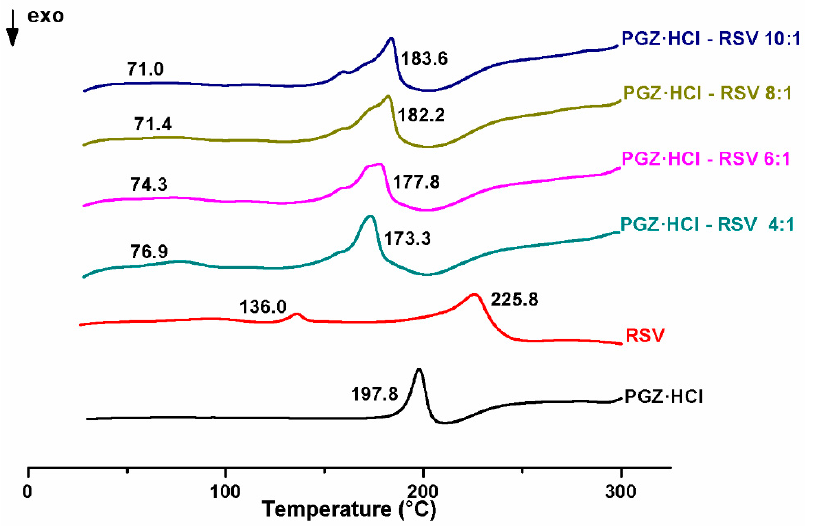
Figure 9. DSC thermograms of the solid forms of PGZ·HCl-RSV at different stoichiometric ratios